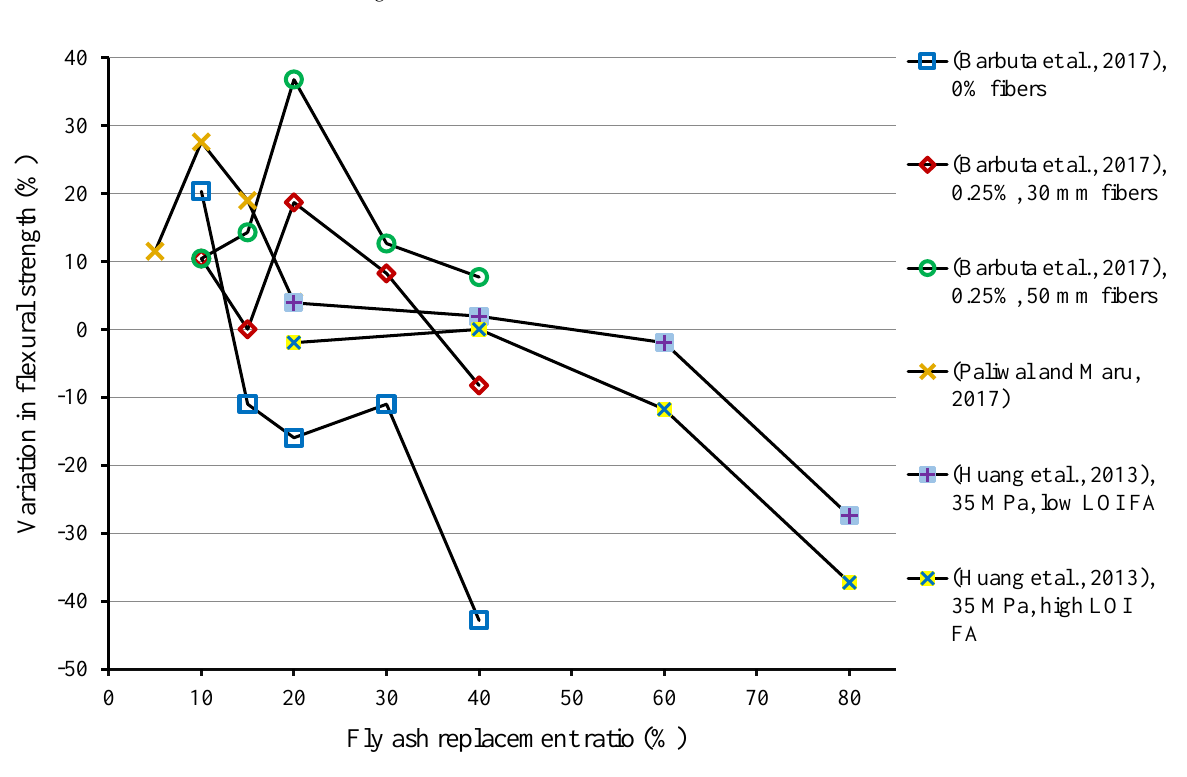
Figure 4. Influence of fly ash as cement replacement on 28-days flexural strength of composites [107,109,115].